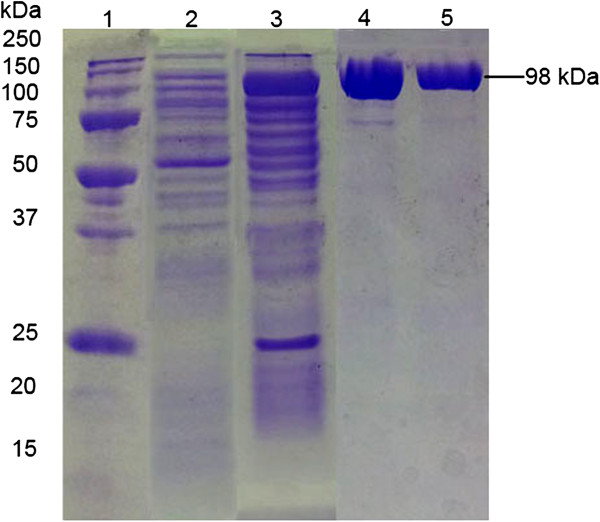
SDS-PAGE analysis shows the purified rPPDK. Lane 1: Precision Plus Protein™ Unstained Standard Marker (Bio-Rad, USA); Lane 2: Non-induced cell from pET28a/PPDK; Lane 3: Induced cell from pET28a/PPDK; Lanes 4–5: purified rPPDK protein from elution buffer (250 mM imidazole). Arrow indicates the recombinant PPDK protein (~98 kDa).